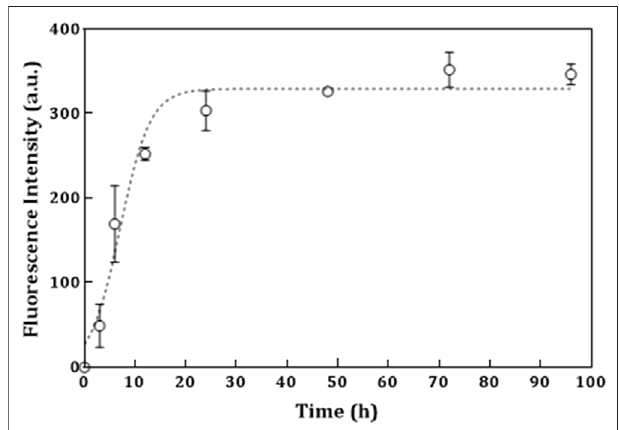
FIGURE 2 | Kinetics studies of tau protein fi bril formation induced by heparin in the presence of DTT. ThT fl uorescence used to monitor kinetics of 20 µM tau protein induced by 5 M heparin in the presence of DTT at 37 ° C in 50 mM Tris-HCl buffer of pH 7.6 and 100 mM NaCl. The continuous line through the data points is a least square fi t to a sigmoidal equation. The error bars represent the spread in the data calculated from three independent experiments. The kinetic parameter k app (the apparent rate constant) was calculated to be 2.78 × 10 – 1 h − 1 , with Tm of 7.498 h and Fmax of